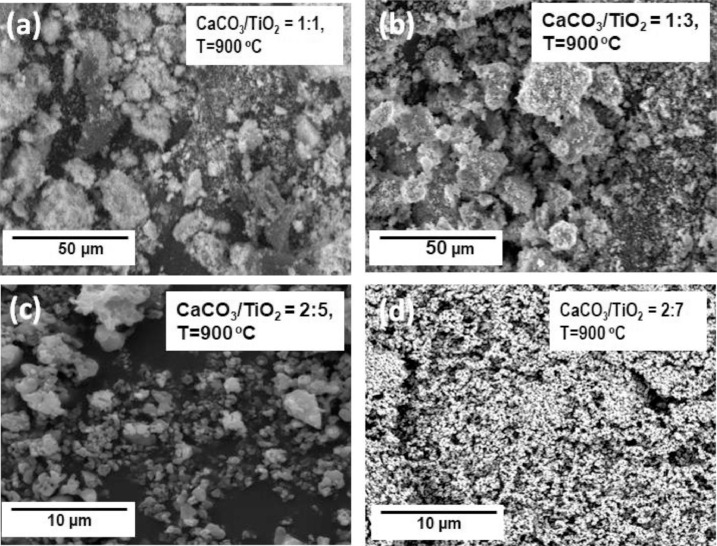
Scanning electron micrographs of CaTiO3 prepared using different CaCO3/TiO2 molar ratio, i.e. (a) (1:1), (b) (1:3), and (c) (2:5). All samples were annealed at 900 °C for 4 h.